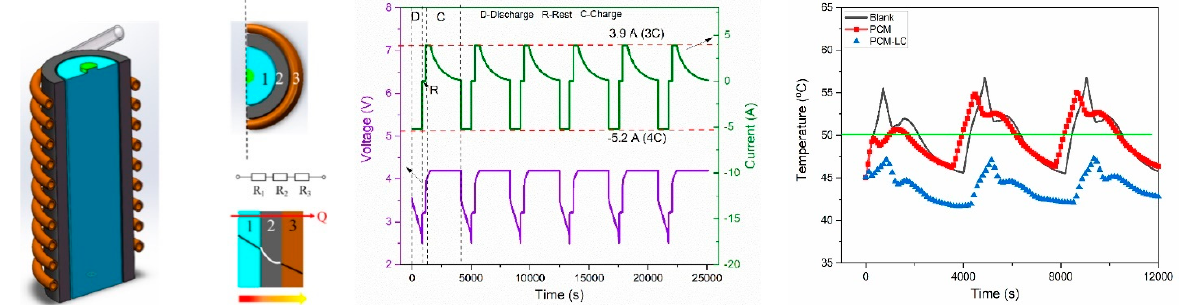
Figure 26. ( Left ): The hybrid BTMS described in [101]; ( Middle ): thermal cycling load; ( Right ): Battery temperature. Reproduced with permission from Elsevier.